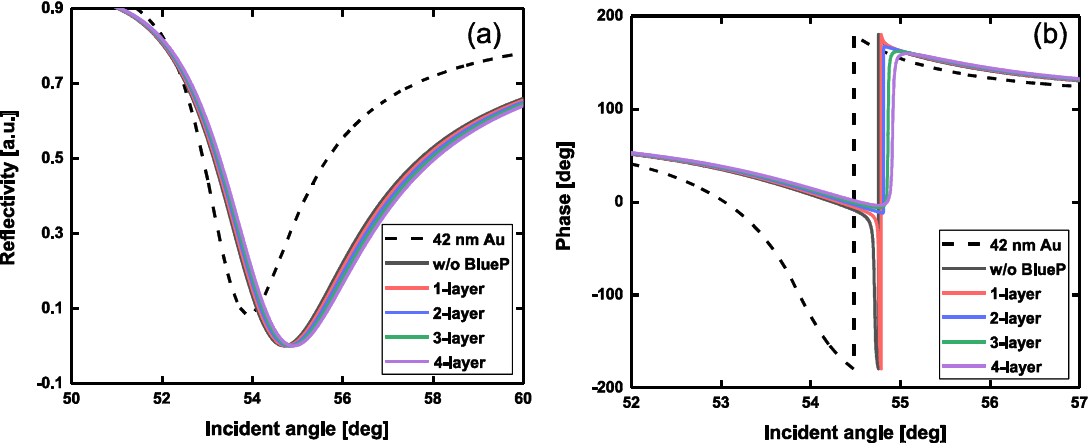
Figure 4. Variation of reflectivity ( a ) and phase ( b ) with respect to the incident angle by changing the number of BlueP interlayers ranging from 0 to 4 layers. The Au film thickness is 42 nm. The number of graphene is 4. The incident wavelength is 632.8 nm. Note: the black dotted curve in Figure 4a stands for the SPR reflectance originating from the 42 nm Au film. The black dotted curve in Figure 4b denotes the SPR phase originating from the 42 nm Au film.